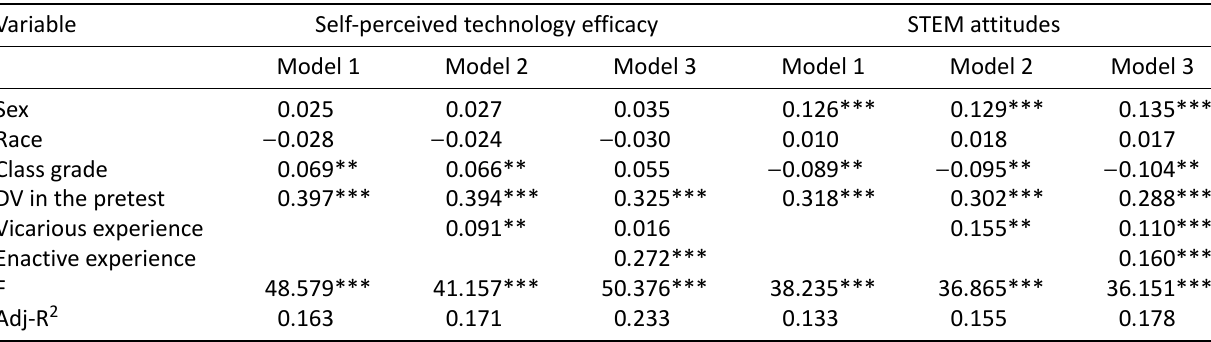
Table 2. OLS regression analysis of student’s self-perceived technology efficacy and STEM attitudes regressed on enactive and vicarious